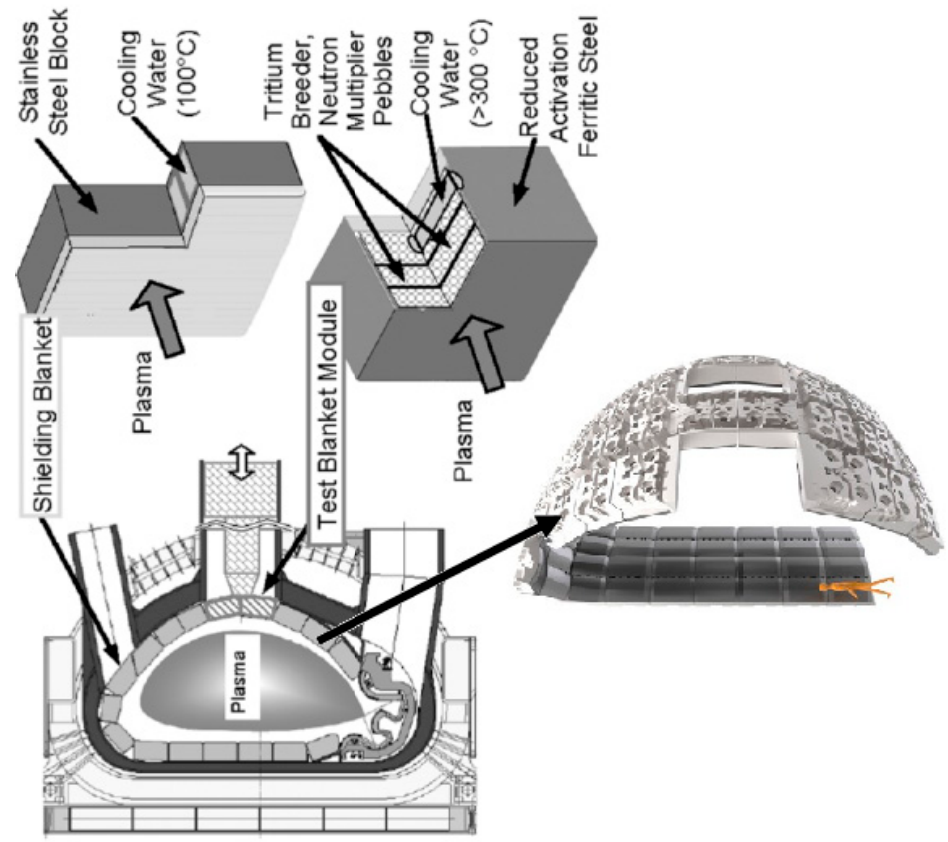
Figure 1. Blanket modules covering the inner walls of the vacuum vessel with zooming of the module